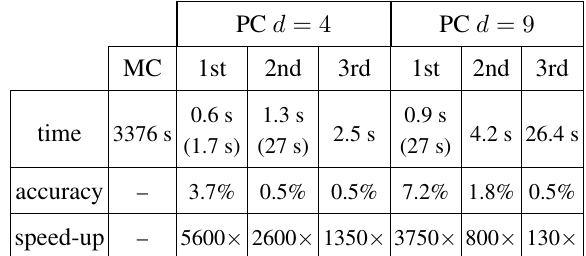
Table 2: Simulation times and accuracy for the ribbon cable